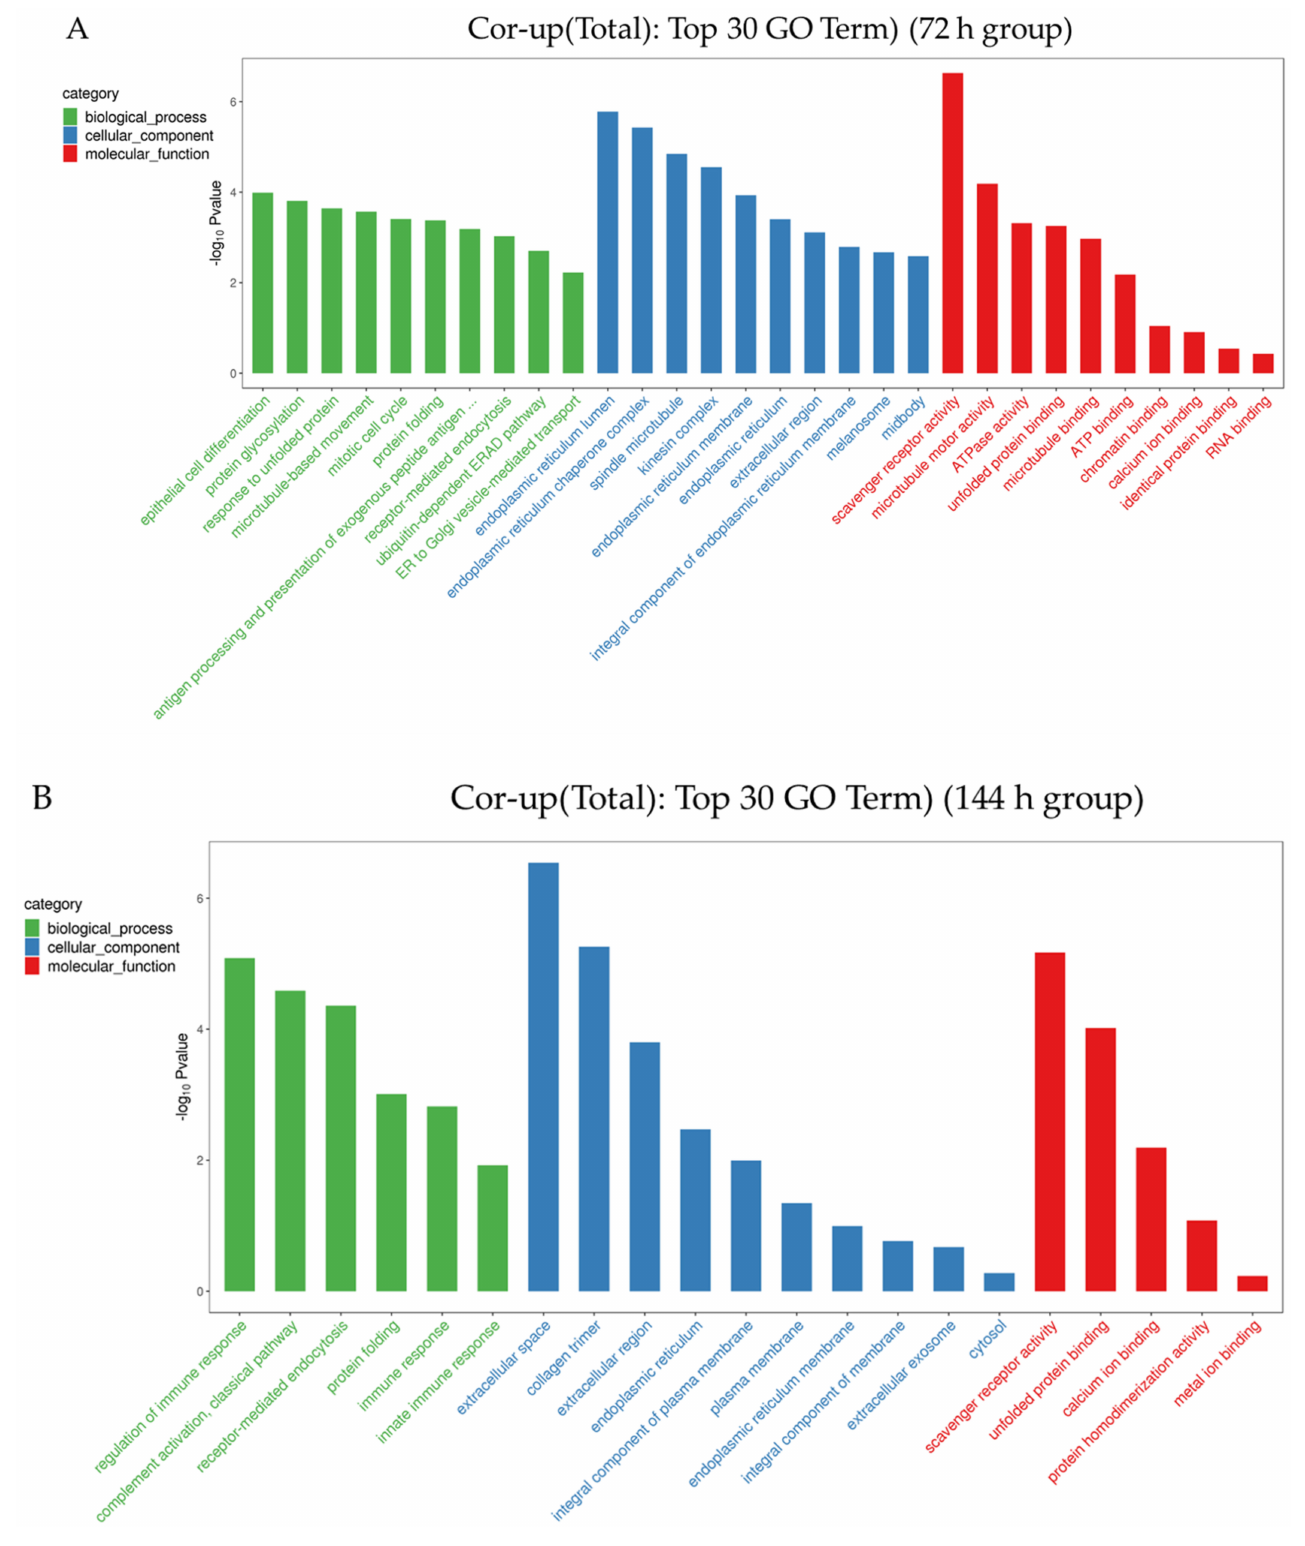
Figure 4. The enriched GO (gene ontology) terms concluding the biological process, molecular function and cellular component of co-upregulated proteins and transcriptome in different groups (( A ) means 72 h, ( B ) means 144